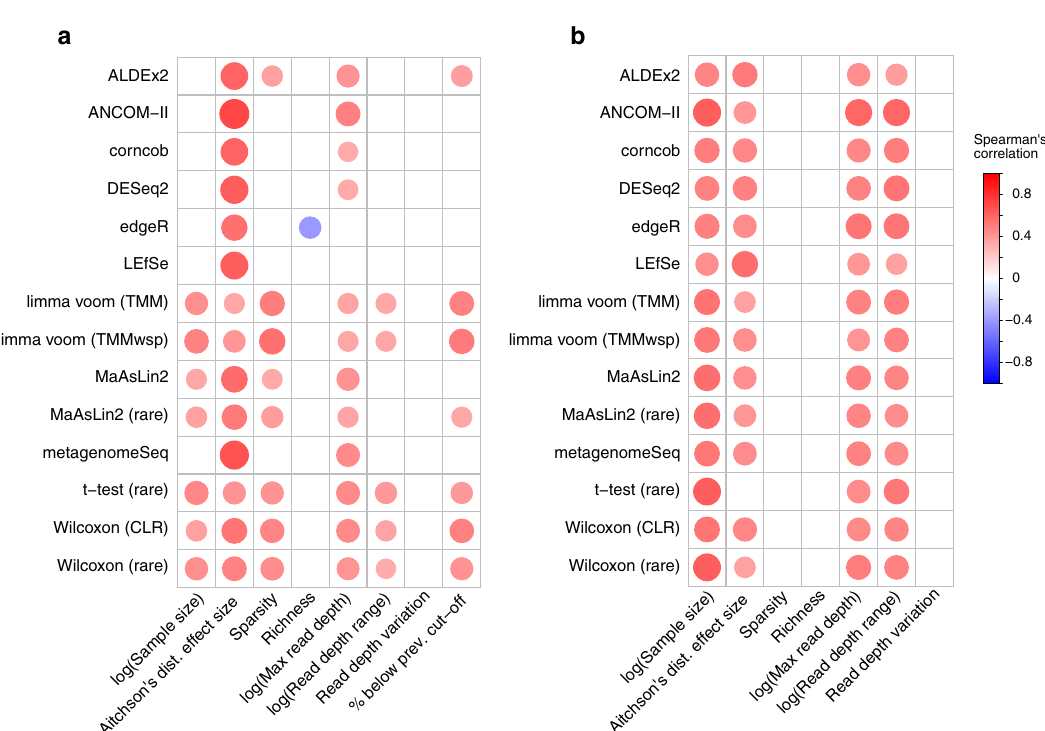
Fig. 2 Dataset characteristics associated with percentage of signi fi cant amplicon sequence variants. The correlation coef fi cients (Spearman ’ s rho) are displayed by size and color for the a un fi ltered and b prevalence- fi ltered data. These correspond to the dataset characteristics correlated with the percentage of signi fi cant amplicon sequence variants identi fi ed by that tool per dataset. Only signi fi cant correlations before multiple comparison correction ( p < 0.05) are displayed. Abbreviations: prev., previous; TMM, trimmed mean of M-values; TMMwsp, trimmed mean of M-values with singleton pairing; rare, rare fi ed; CLR, center-log-ratio. Source data are provided as a Source Data fi